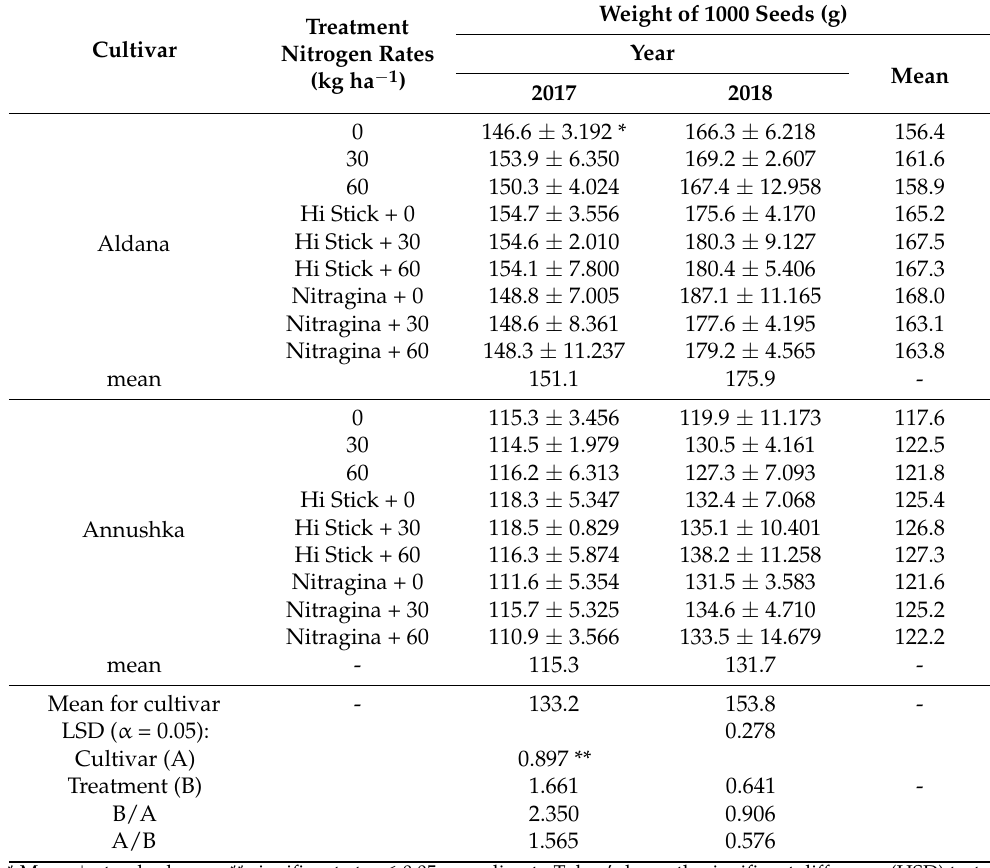
Table 2. Weight of 1000 seeds and humidity of seeds depending on the mineral N fertilization applied and the inoculation.